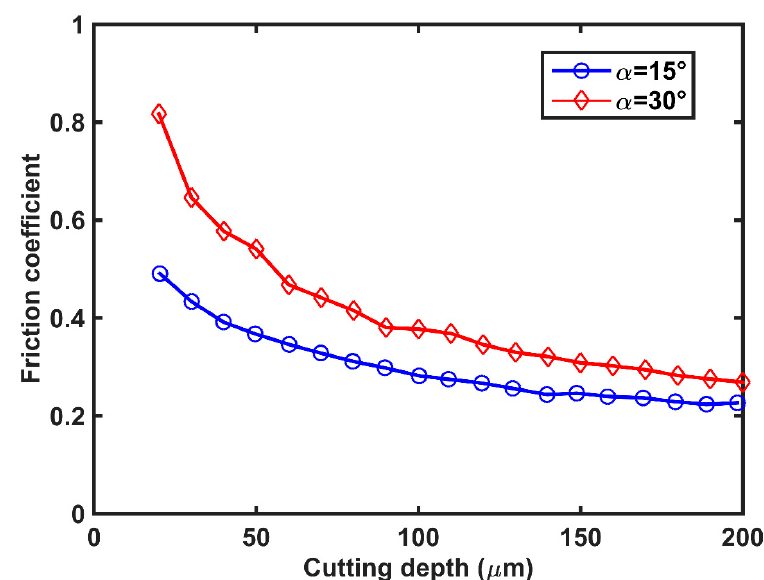
Figure 6. Friction coefficient as a function of cutting depth in HDPE.